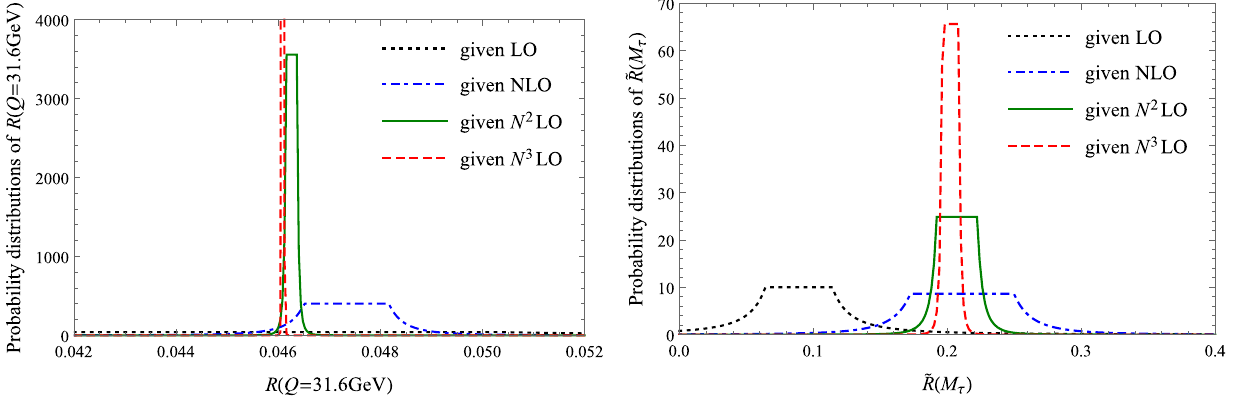
Fig. 2 The predicted credible intervals (CI) with three typical DoBs for the scale-dependent coefficients r i (μ r ) at the scale μ r = M τ and the scale-invariant r i , 0 of ˜ R n ( M τ ) under the Bayesian-based approach, respectively. The red diamonds, the blue rectangles, the golden yellow